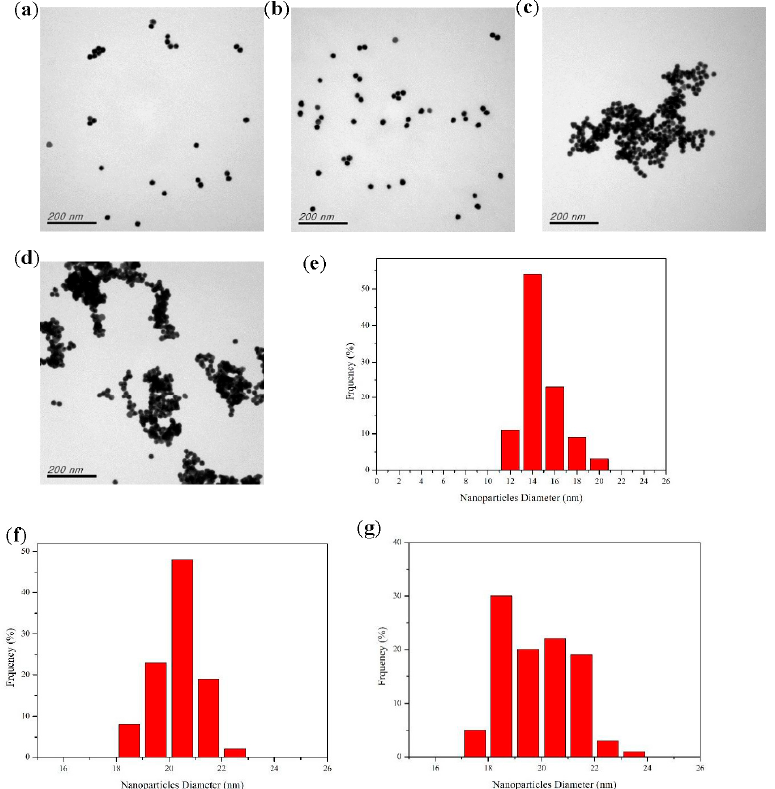
Figure 2. TEM images of ( a ) AuNPs + NaNO 2 , ( b ) AuNPs + NaNO 2 + PBS bu ff er, ( c ) AuNPs + NaNO 2 + PBS bu ff er + Ace, ( d ) AuNPs + NaNO 2 + PBS bu ff er + Nap, and the size distribution of ( e ) AuNPs + NaNO 2 + PBS bu ff er, ( f ) AuNPs + NaNO 2 + PBS bu ff er + Ace, and ( g ) AuNPs + NaNO 2 + PBS bu ff er + Nap. When the sodium citrate reduced the gold nanoparticles, the citrate anions a tt ached to the gold nanoparticles reduced the gold ions to atoms and stabilized colloidal AuNPs formed from the cluster. The concentration relative to the gold precursor was high. In addition, NaNO 2 is hygroscopic, so it can easily dissociate Na + and NO 2 − ions, a process known as the denitri fi cation mechanism. As a consequence, the colorimetric detection of acenaphthene and naphthalene is based on the above mechanism (Figure 3). These two analytes had electrophilic substitution reactions and were more reactive. The negatively charged NO 2 − ions were drawn to the selected analyte as a result of the negatively charged gold nanoparticles being drawn toward positively charged sodium ions. Therefore , the dispersed functionalized AuNPs resulted in aggregation and the solution changed from dark red to dark blue.